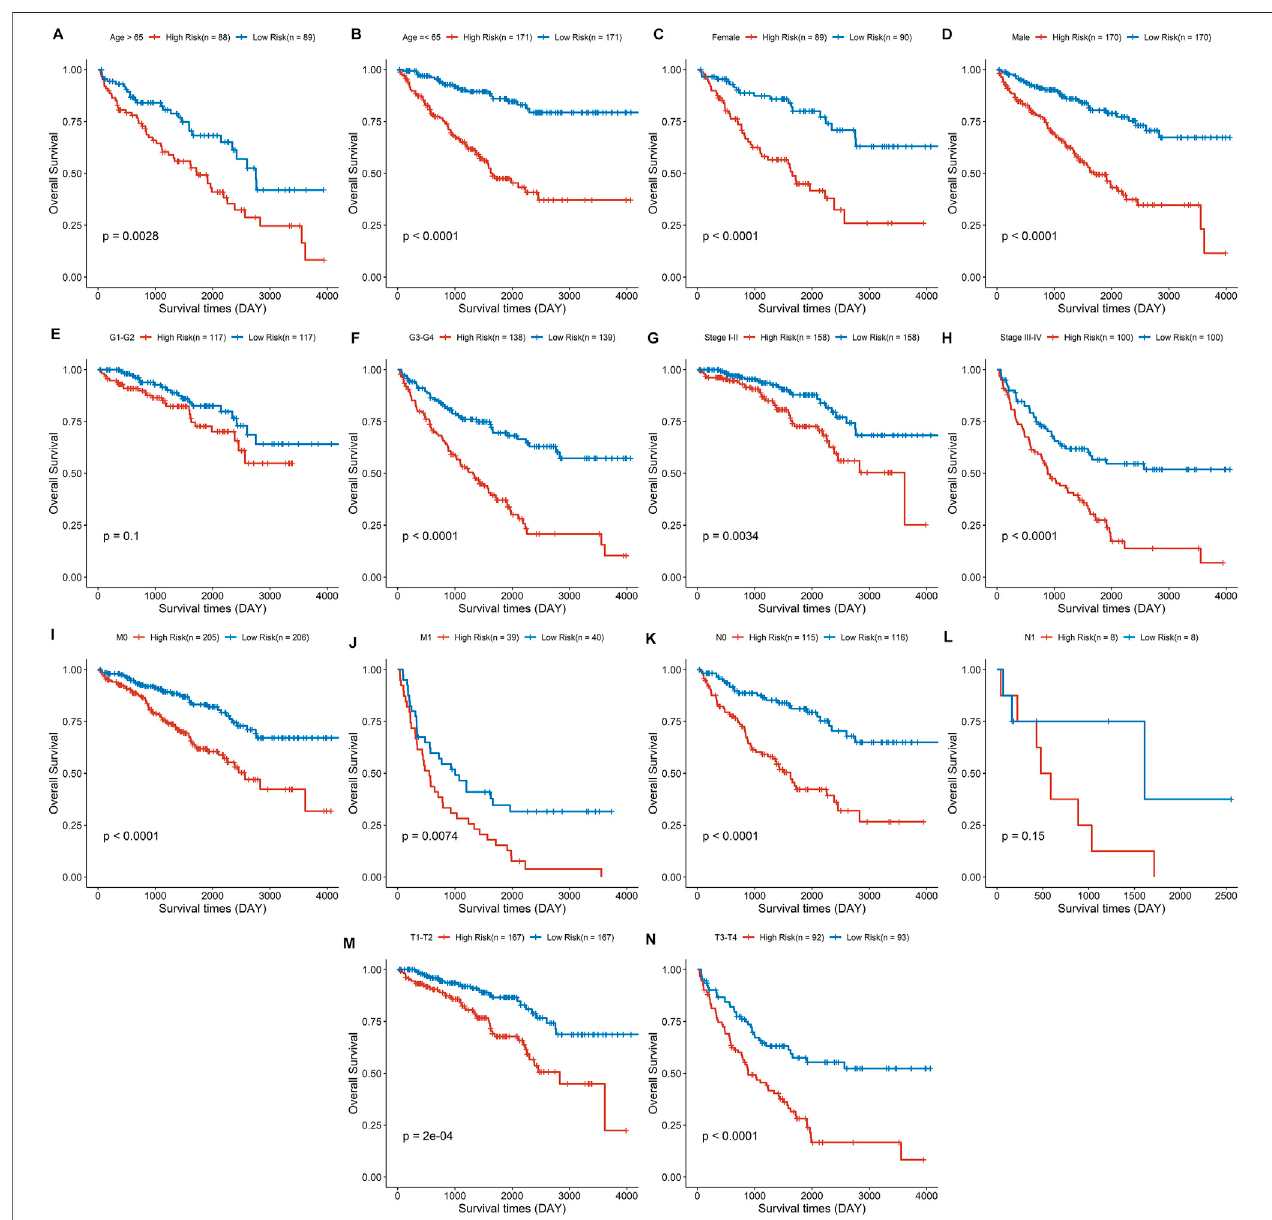
FIGURE 8 | Survival analysis for the high- and low-risk group strati fi ed by age (A,B) , sex (C,D) , pathological grade (E,F) , clinical stage (G,H) , distant metastasis (I, J) , lymph node invasion (K,L) , and tumor size (M,N) .